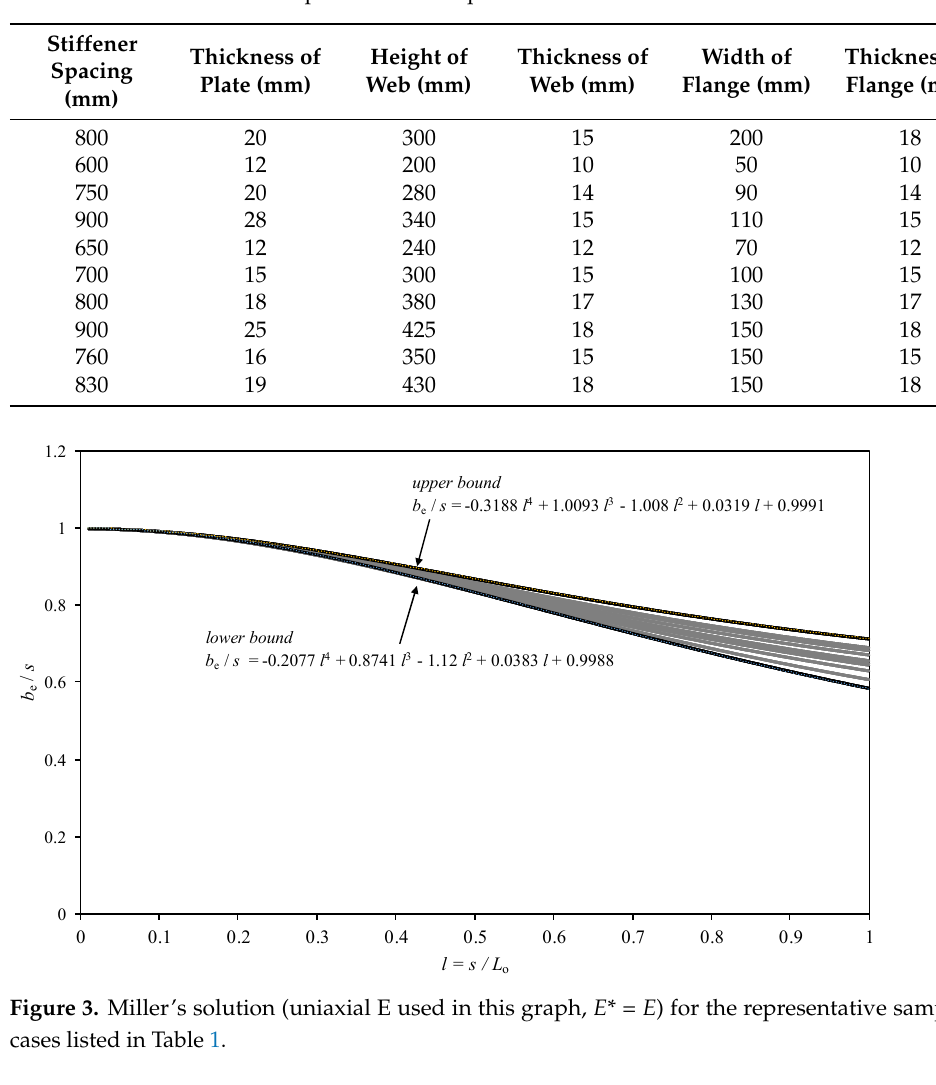
Figure 3. Miller’s solution (uniaxial E used in this graph, E * = E ) for the representative sample of cases listed in Table 1. Table 1. Dimensions of “Tee” profile stiffened panels.